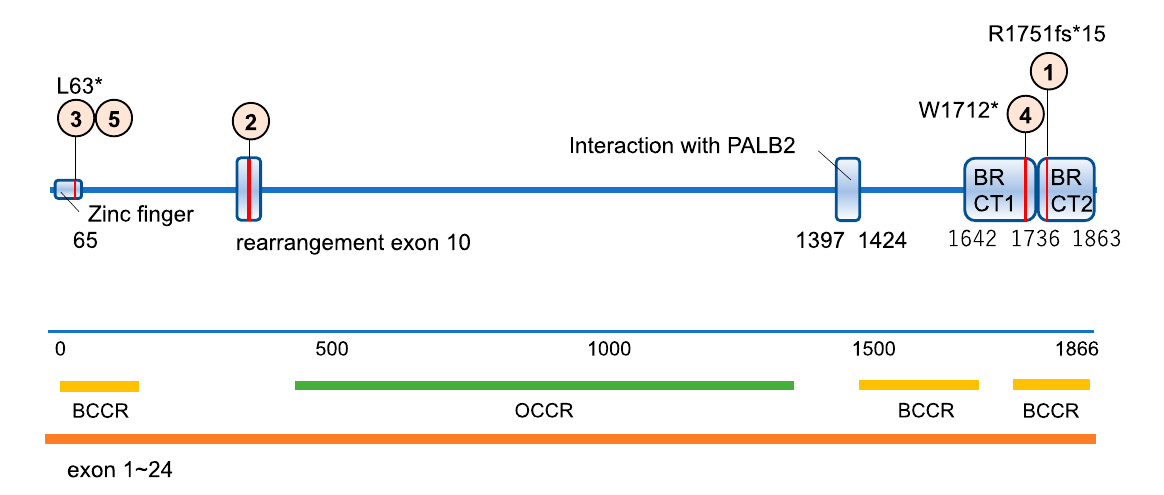
Figure 3. The diagram of a BRCA1 protein structure [120]: It is composed of 24 exons and 1866 Amino acids. In (HM)-SCREEN-Japan, five cases with pathogenic or germline BRCA1 variants were detected. Positions of these variants are shown above with red vertical lines on the BRCA1 protein. There are a number of hotspots where cancer related genes are located. BCCR and OCCR are the hotspots where a majority of hereditary breast and ovarian cancer related genes are located. * Case 1, 3, 4 and 5 were located on the BCCRs and case 2 was considered as pathogenic according to ClinVar, which suggested the BRCA gene variants might be related to AML